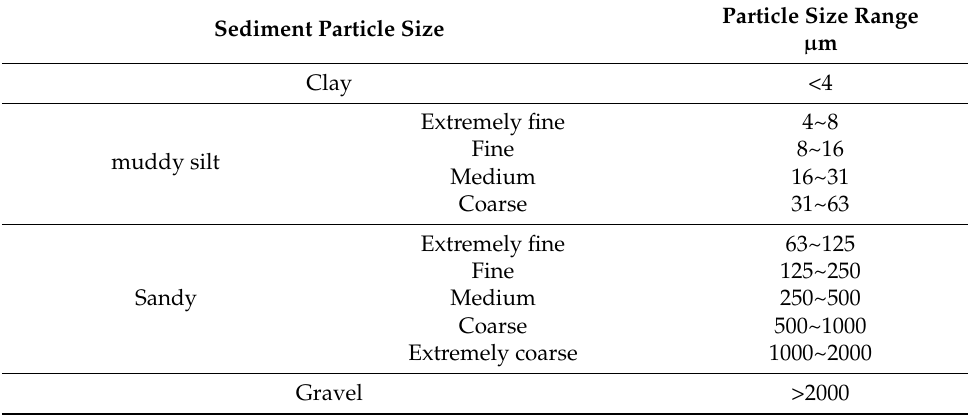
Table 1. Particle size classification table of marine sediment.